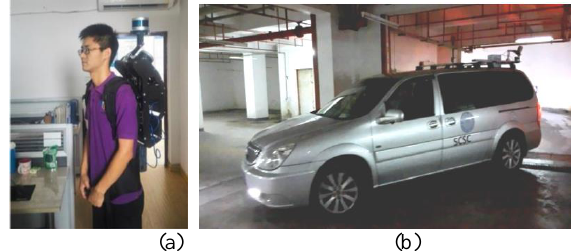
Figure 1. (a) Upgraded backpacked laser scanning system (Wang et al., 2018). (b) Car-mounted mobile laser scanning system.